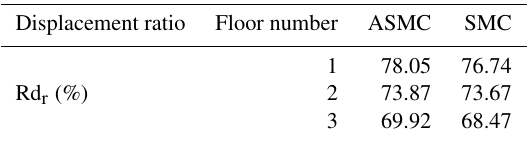
Table 2. The peak displacement reduction ratio of the SMC and ASMC during the 1940 El Centro earthquake.